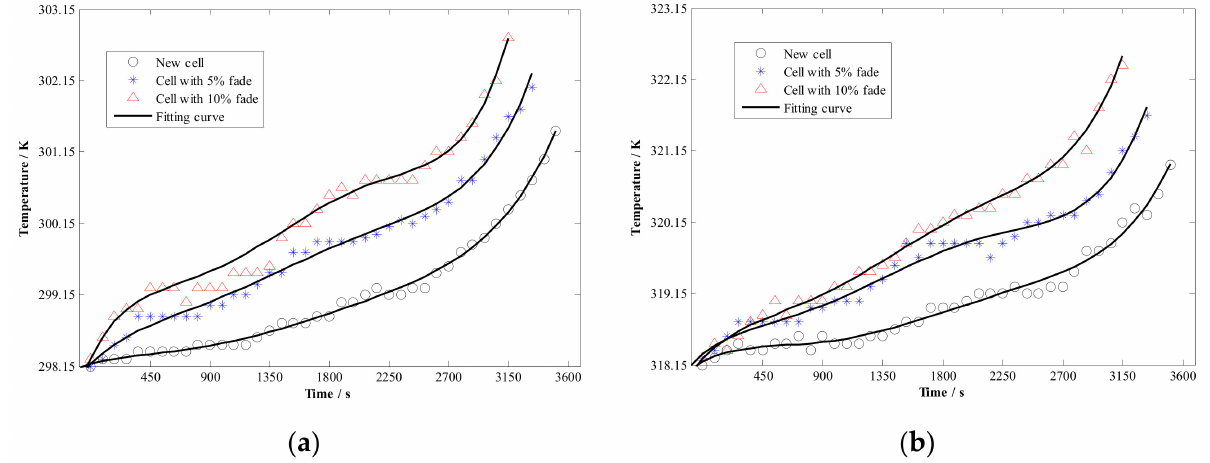
Figure 5. Experimental result of battery temperature; ( a ) ambient temperature 298.15 K; ( b ) ambient temperature 318.15